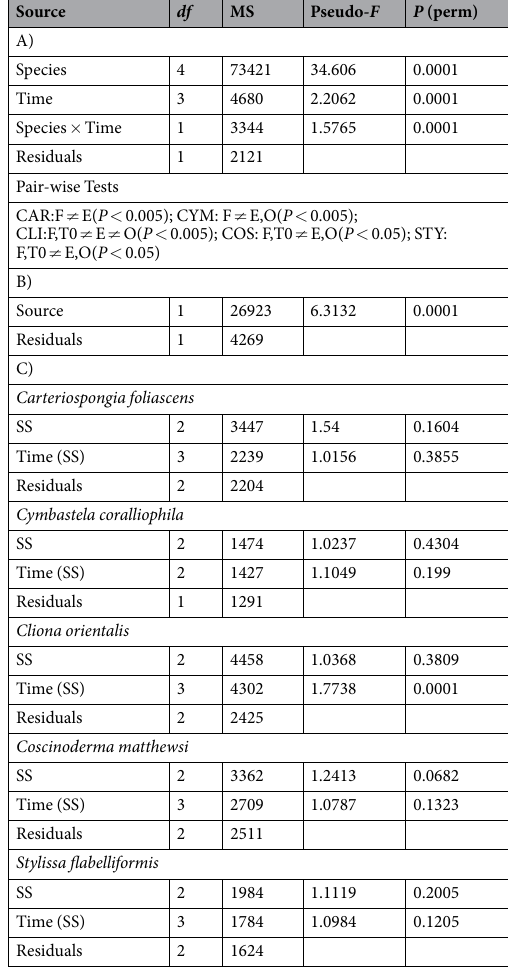
Table 3. PERMANOVA analyses of the sponge-associated microbiome with (A) species and time as factors, (B) source as factor (sponge host vs. seawater) and, (C) SSC and time (nested to SSC) as fixed factors for all five sponge species. In pair-wise tests, F: field control, T0: time 0 control, E: sampling after the 28 d experimental period, O: sampling after the 14 d observational period; CAR for Carteriospongia foliascens , CYM for Cymbastela coralliophila , CLI for Cliona orientalis , COS for Coscinoderma matthewsi and STY for Stylissa flabelliformis ; 0, 30 and 100 mg L − 1 within